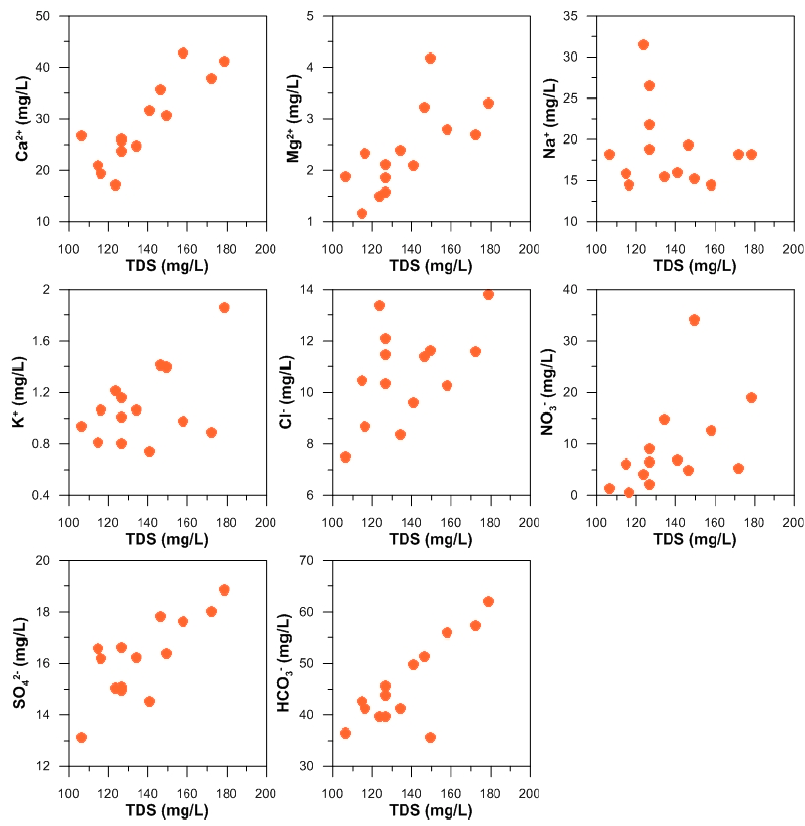
Figure 4. Variations in major ions according to TDS.